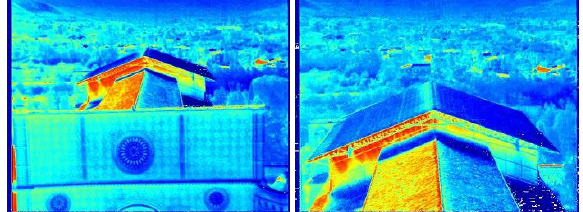
Fig. 11. The final true-orthophoto from the UAV project. The final GSD is 13.5 mm, i.e. more than sufficient to obtain a true-orthophoto with scale factor 1:100. As can be seen, the algorithm detected occluded areas that remains invisible. It avoids the ghost effect and creates black areas in the final true- orthophoto.